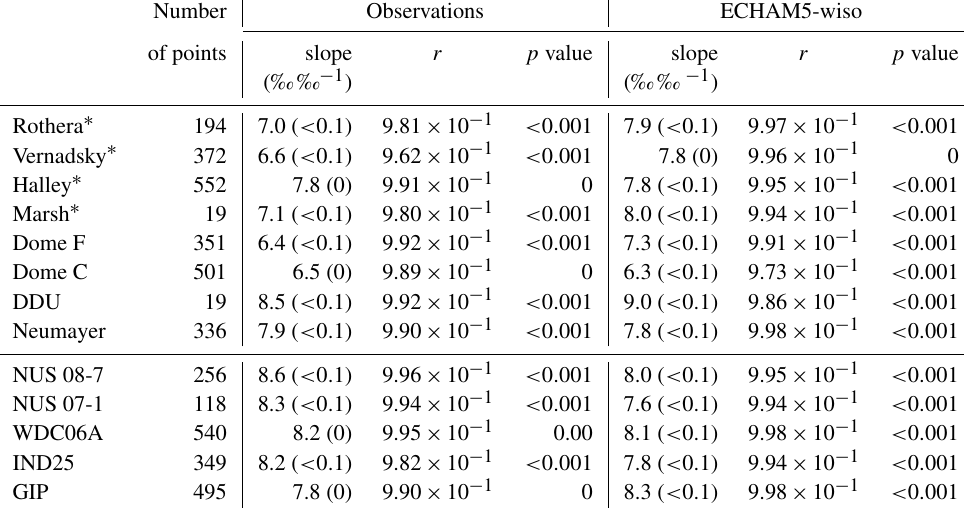
Table 6. Slope (in ‰‰ − 1 ), correlation coefficient, and p value of the δ 18 O– δ D linear relationship from precipitation measurements (top of the table) and ice core data (bottom of the table) over the available period at daily or monthly scale (identified with an asterisk) and from the ECHAM5-wiso model over the observed period at the time resolution of the data for the precipitation and at the annual scale for the ice core data. Numbers in brackets correspond to the standard errors.